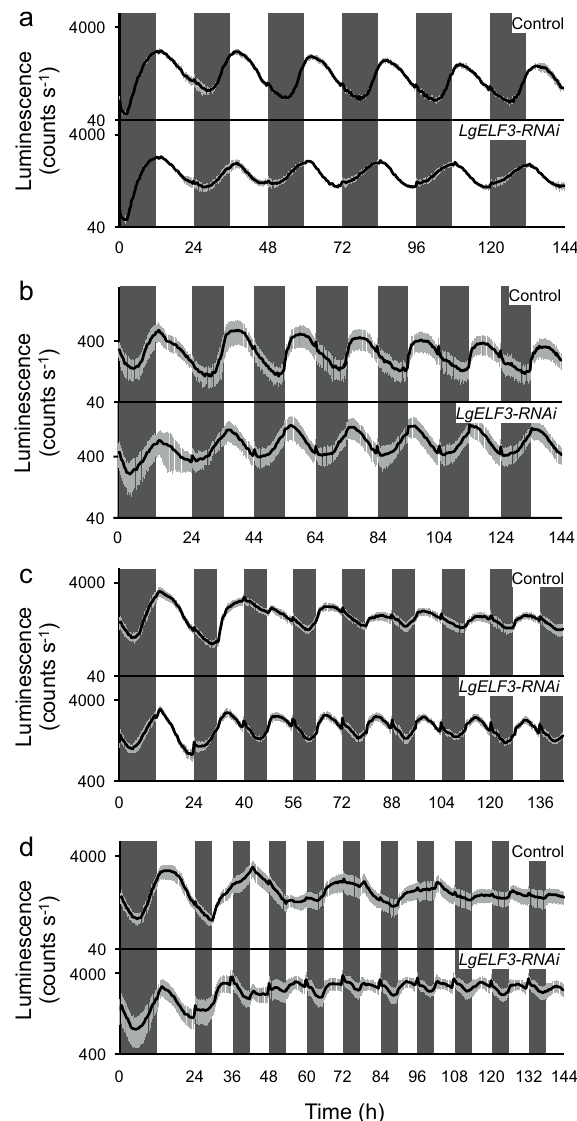
Figure 2. Entrainability of the circadian rhythm to various T-cycles at a whole plant level and its alteration by the LgELF3 knockdown. The bioluminescence of the AtCCA1::LUC reporter was measured under various light/ dark cycles (T-cycles), T = 24 h ( a ), 20 h ( b ), 16 h ( c ) and 12 h ( d ). Black lines and grey bars represent the mean value and SD values, respectively. Three independent experiments with three or four replicate dishes each were conducted and a representative trace for each condition is shown. The shaded boxes indicate the duration of the dark periods in the light/dark